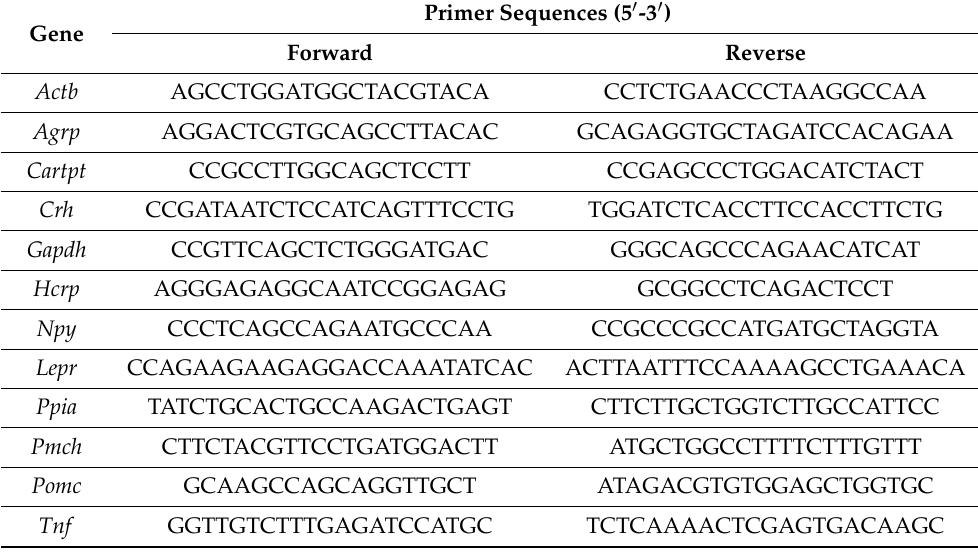
Table 1. Primers used on the hypothalamus qPCR.